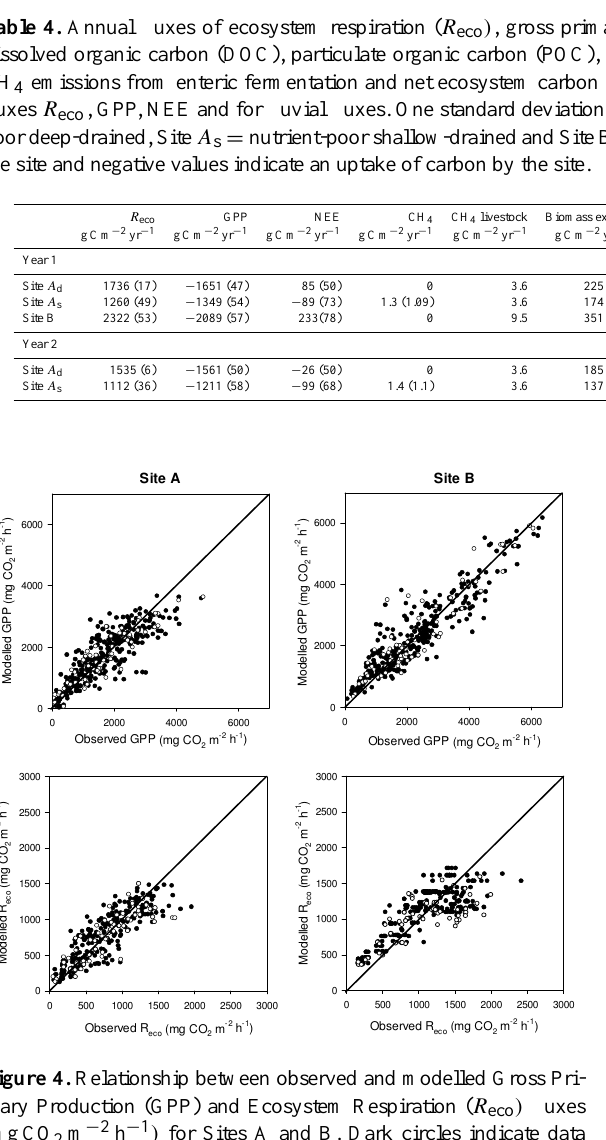
) together with biomass exports, 3